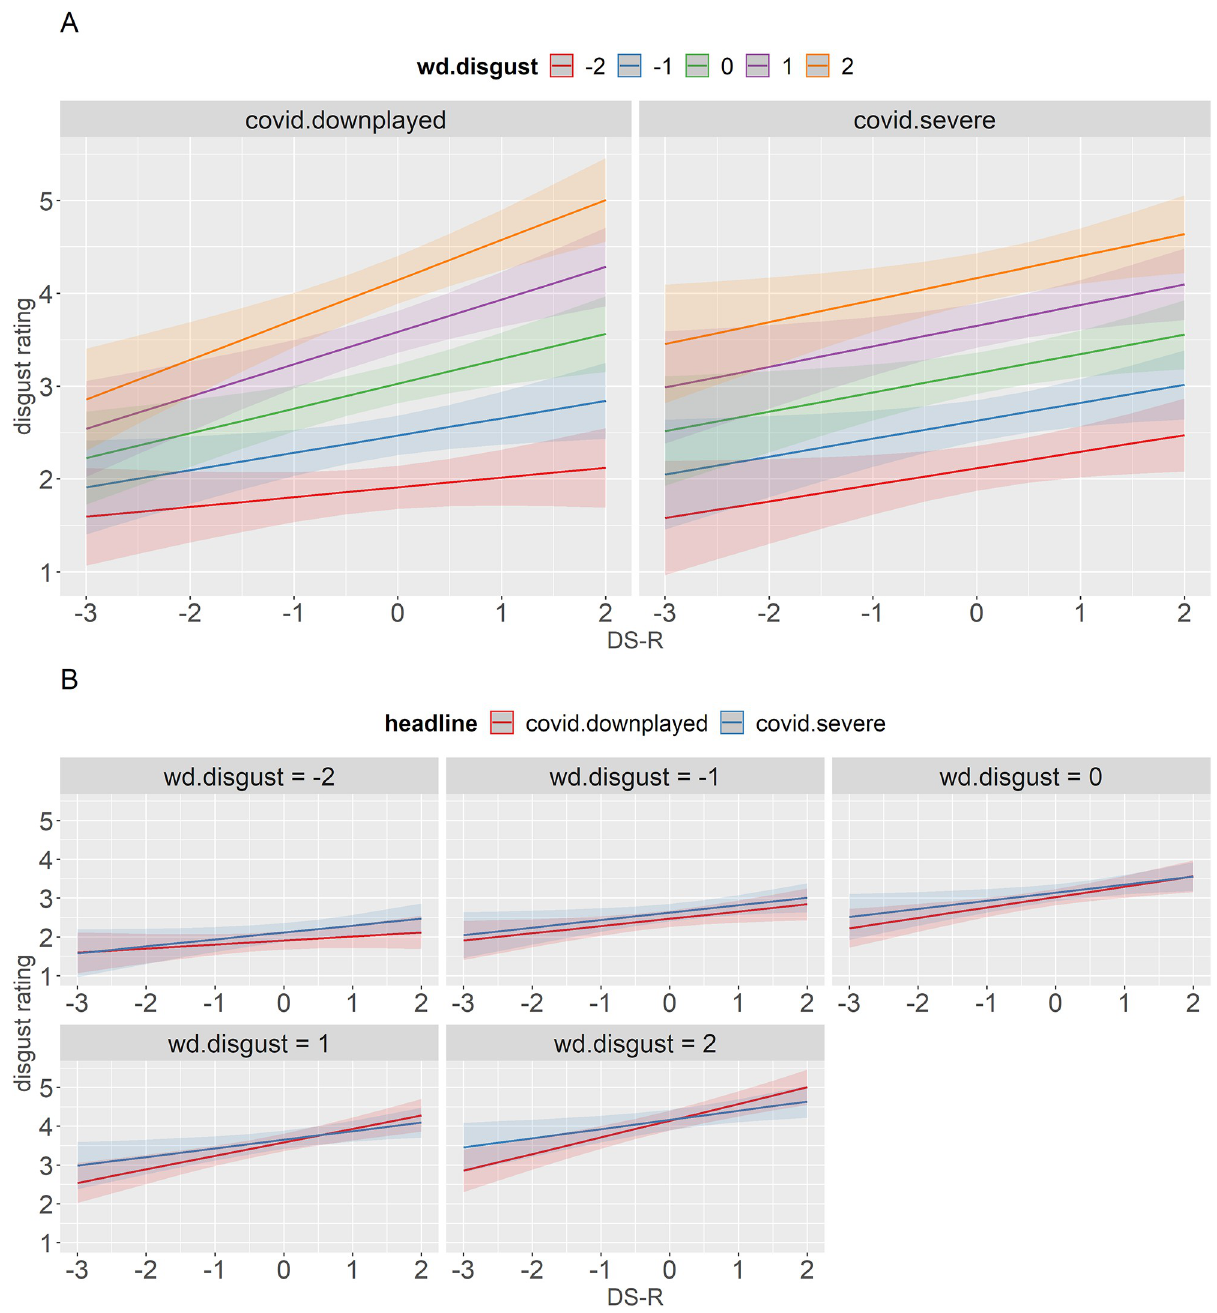
Fig 2. Predicted values (marginal effects) of the interaction between DS-R, word disgust, and headline with disgust rating as a dependent variable. Panel A shows a breakdown by headline, Panel B shows a breakdown by word disgust. https://doi.org/10.1371/journal.pone.0271206.g002 the downplayed condition only. The lines for the quantiles of word disgust are virtually parallel following the severe headlines, reflecting main effects of word disgust and DS-R, whereas they are fan-shaped following the downplaying ones. High-disgust words (disgust index > 0) had a much steeper slope than low-disgust words (disgust index < 0) in the downplayed condition.